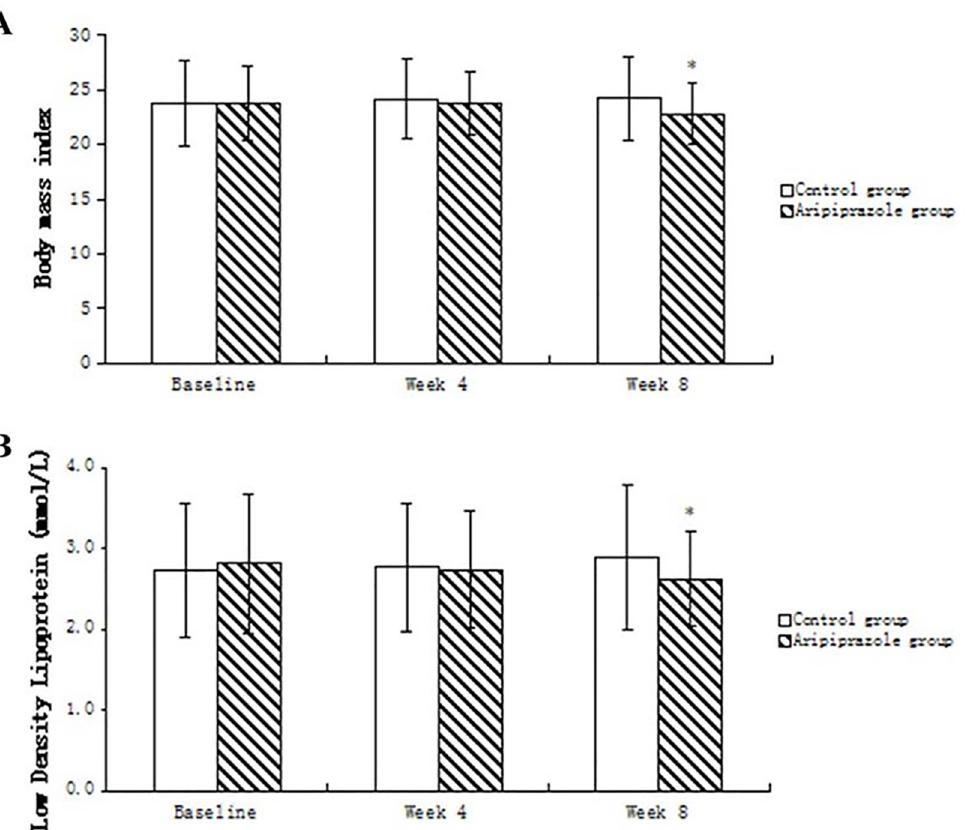
Fig 3. Comparisons of BMIs (A) and plasma LDL levels (B) between groups. Data are expressed as means ± SD and were analyzed byStudent's t-test. * P < 0.05, vs . control.